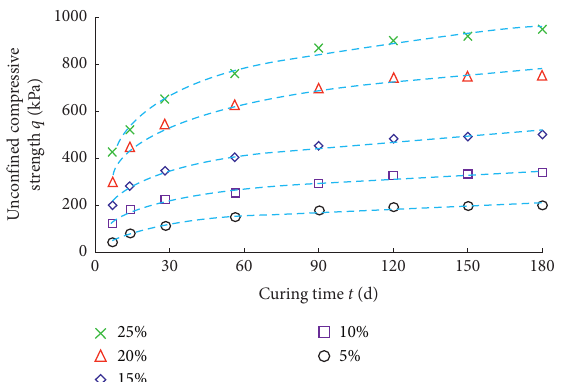
Figure 12: The relationship curves between A, B and the cement content cw.